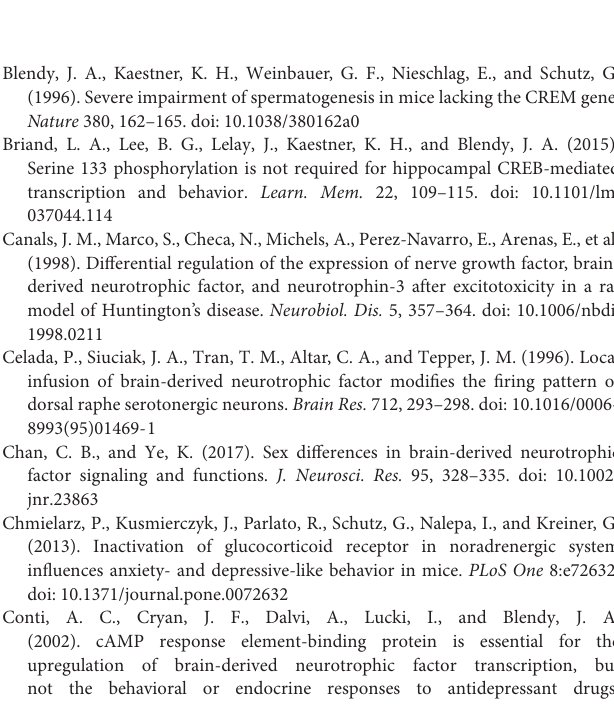
FIGURE S1 | Expression of BDNF in female w/t, Creb1 TPH2CreERT2 , and Creb1 TPH2CreERT2 Crem − / − mice after fluoxetine treatment as visualized by immunohistochemistry. Immunofluorescent staining revealed no visible differences between non-treated w/t and mutant mice (A–C) ; on the other hand enhanced expression of BDNF-positive cells was noted in w/t mice after fluoxetine (D) , an effect no longer observed in transgenic animals (E,F) . Immunofluorescent staining performed on paraffin-embedded 7 µ M microtome cortical slices of female w/t, Creb1 TPH2CreERT2 and Creb1 TPH2CreERT2 Crem − / − mice with anti-BDNF antibody (green). − FLX, saline treatment; + FLX, fluoxetine treatment. Scale bar for all pictures: 25 µ